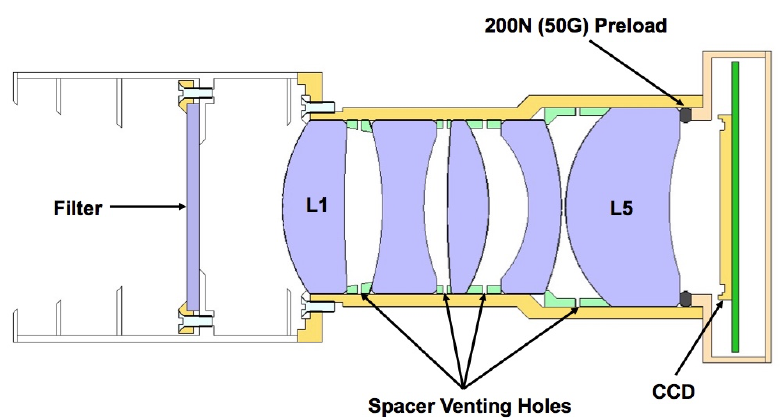
Figure 4. Camera scheme for the U NI BRITE and BRITE-Toronto red instruments with a nearly vignetting free field-of-view of 24 ◦ . The red or blue filters are placed at the entrance pupil of the 5-lens camera to assure a constant filter function over the entire FOV. The blue cameras have slightly modified lens radii and separations to optimise the image quality for the needed wavelength range. Source: